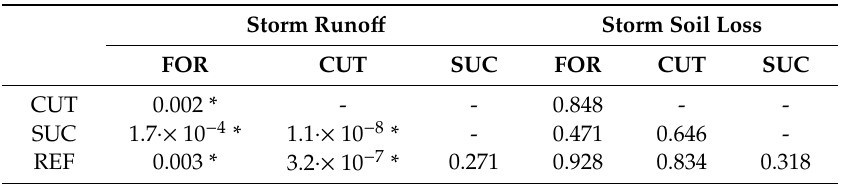
Table 11. Descriptive statistics of standardized modeling results for individual land-management categories: (FOR)ested, (CUT)-down, (SUC)cession and (REF)orested. Table 13. U-test p -values for standardized storm modeling results, (FOR)ested, (CUT)-down, (SUC)CESSION and (REF)orested samples. FOR